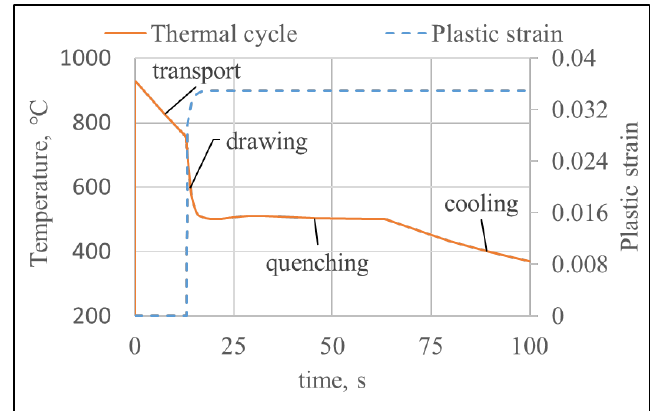
Figure 10. Example of a thermo-mechanical cycle extracted from FE model for USIBOR2000 with quenching time of 50 s and tool temperature of